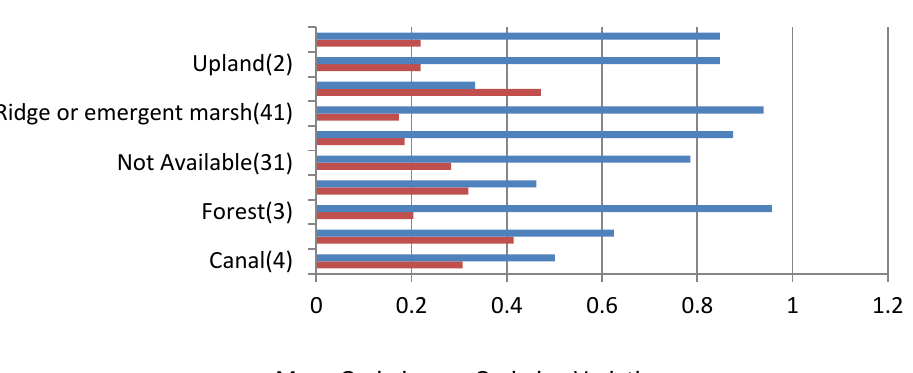
Figure 13. Mean omission rates and variation for gages grouped by field-determined community type. Values in parentheses represent the number of gages classified as that type.